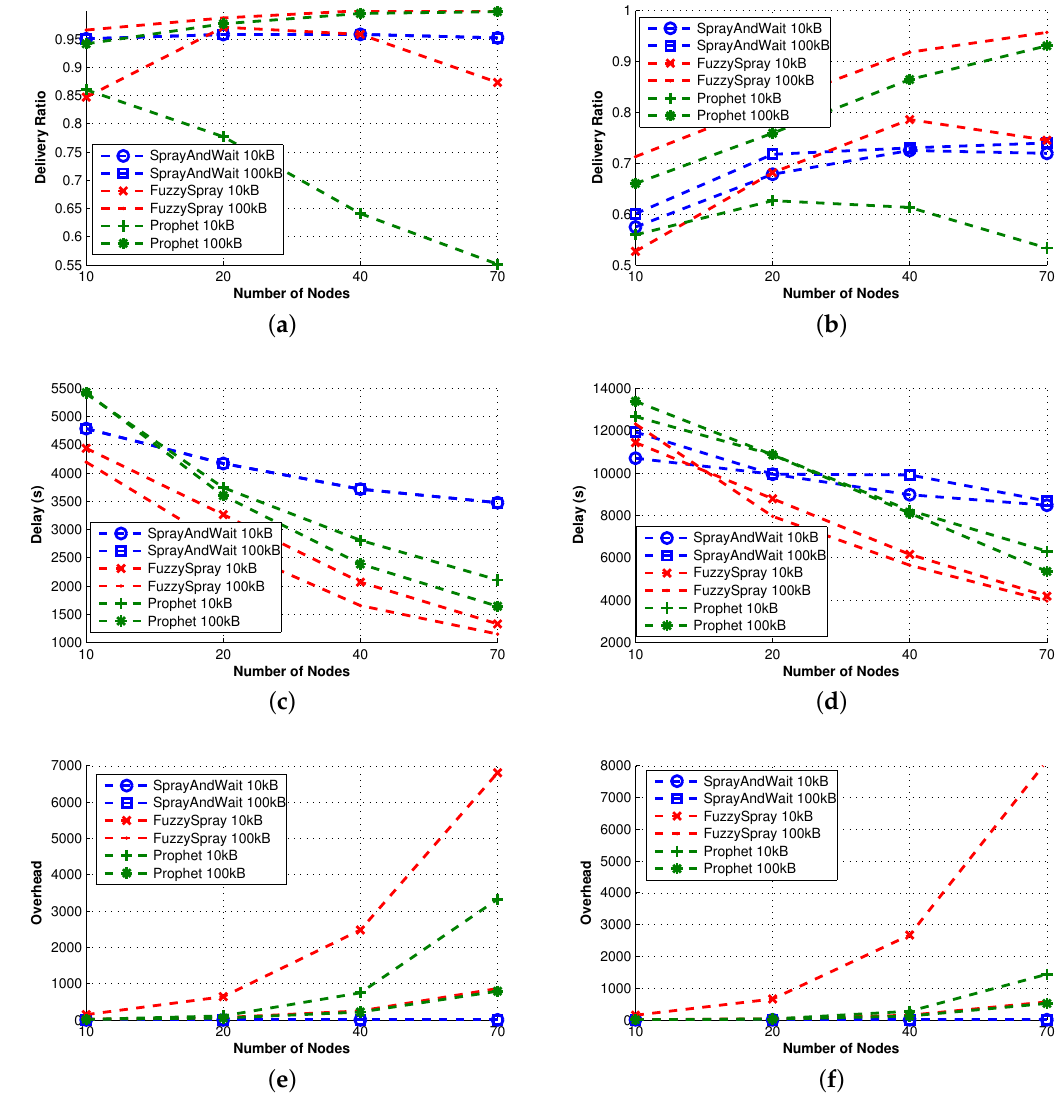
Figure 3. Synthetic traces. Random walk ( a , c , e ); Levy Walk ( b , d , f ). Single technique